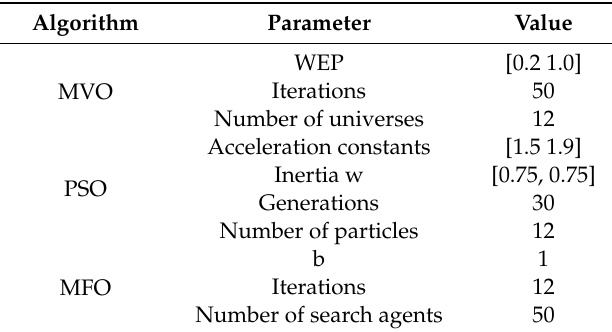
Table 3. Initial parameters of MVO, PSO, and MFO.